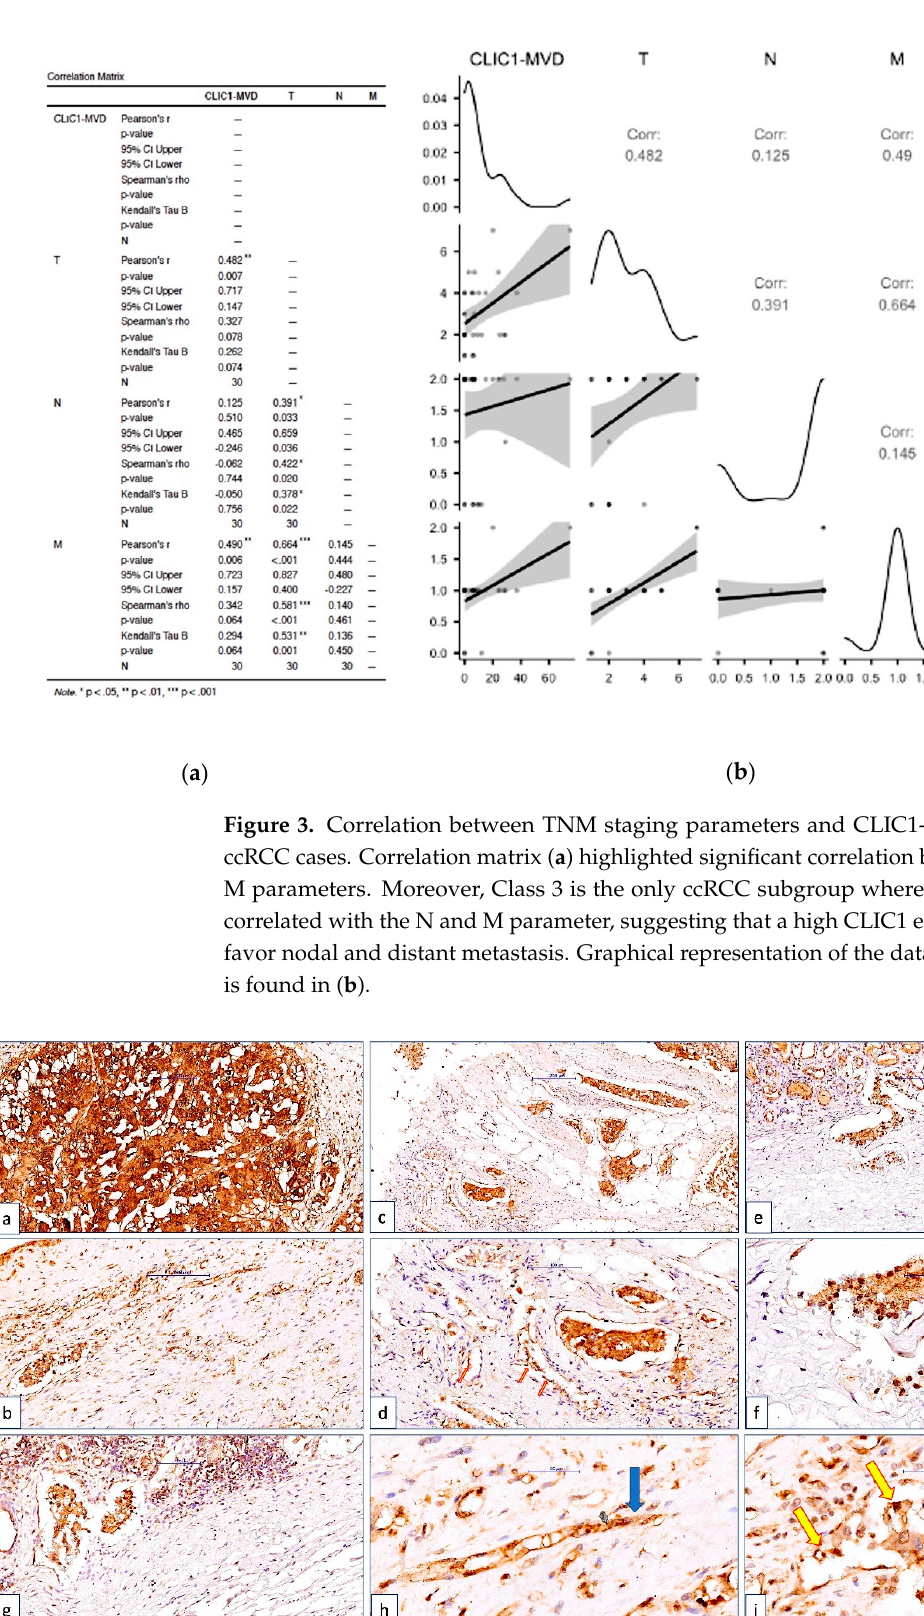
8 of 15 Figure 2. Correlation matrix from statistical analysis applied for Class 1 ( a ) and Class 2 ( b ) ccRCC subgroups related to CLIC1 expression in tumor blood vessels (CLIC1-MVD). Note the lack of sig- nificant correlation for Class 1 ( a ) and the significant correlation between CLIC1-MVD and nodal status N from TNM staging for Class 2 of ccRCC. 3.2.4. CLIC1 Expression was Highest for Class 3 Subgroup Tumor Cells and Significantly Influenced CLIC1-MVD, Tumor Stage, Nodal and Distant Metastasis